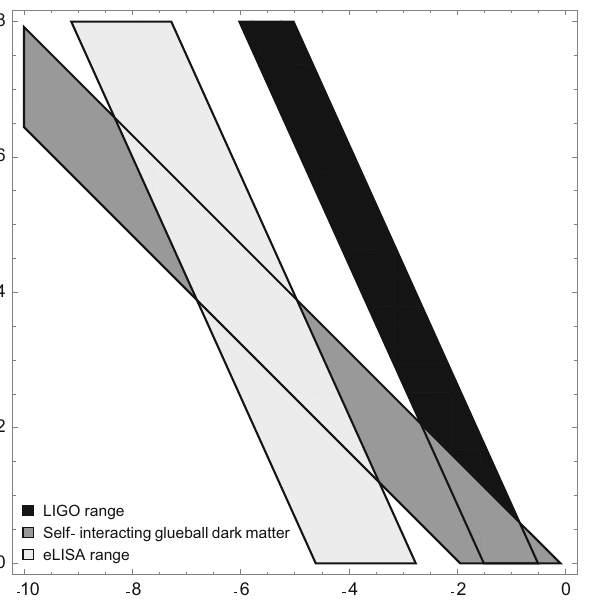
Fig. 5 The m – N parameterspace,fortheself-interactingglueballdark matter, in the current brane tension bound σ (cid:2) 3 . 2 × 10 − 6 GeV 4 [20], for the MGD procedure, corresponding to the EMGD when k = 0. The black (light gray) band shows the gravitational wave peak frequency to be detected by the LIGO (eLISA) experiment, whereas the gray band showsthegravitationalwavepeakfrequencyemittedfromSU( N )MGD dark star mergers